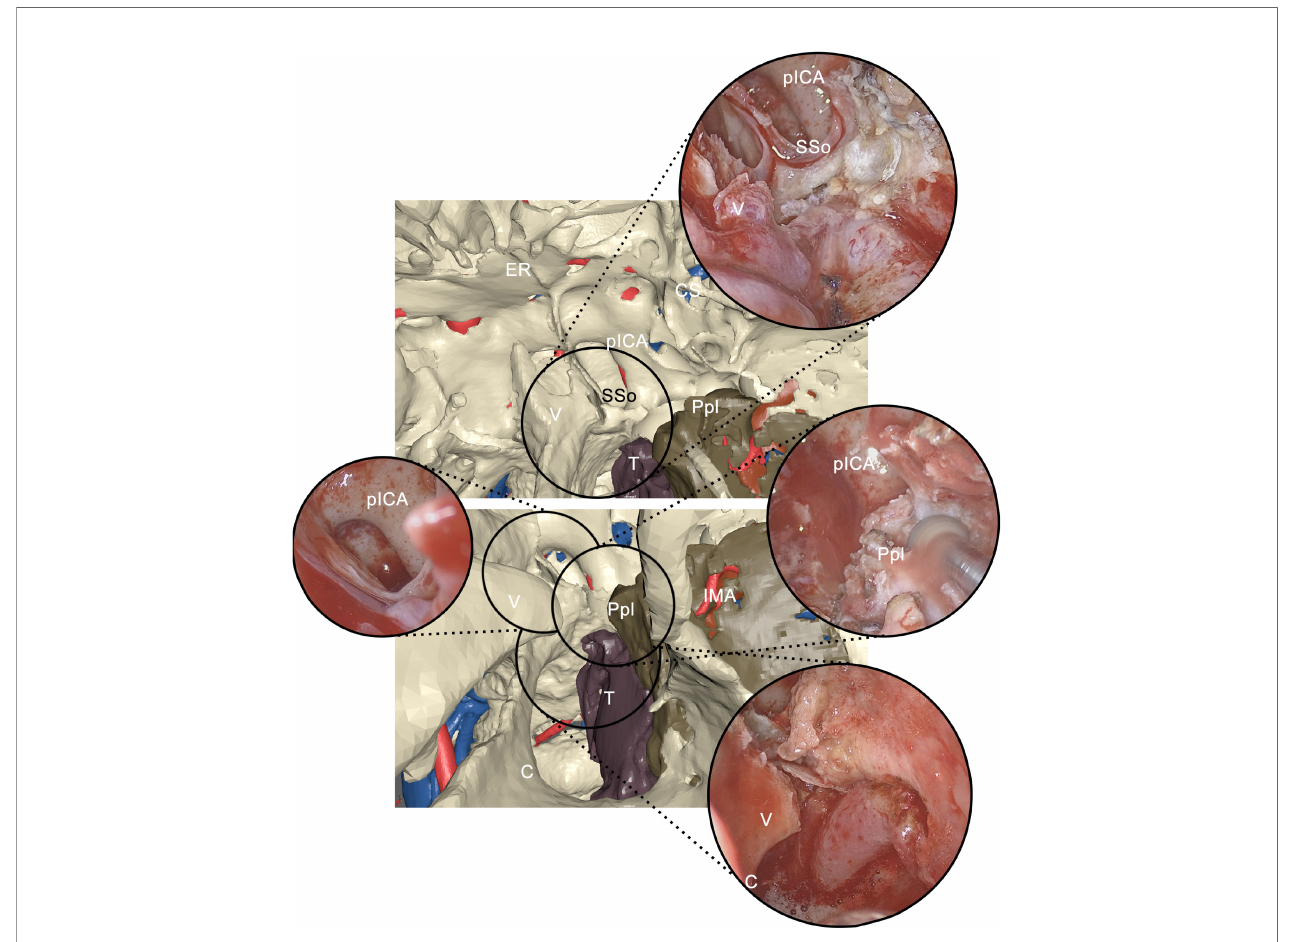
FIGURE 6 | Correlation between virtual endoscopy and real endoscopy using anatomical landmarks. Virtual endoscopy allows to anticipately examine the endoscopic view. pICA, paraclival internal carotid artery; SSo, sphenoid sinus opening; CS, cavernous sinus; ER, ethmoidal roof; V, vomer; Ppl, pterygoid plate; T, tumor; C, choana; IMA, internal maxillary